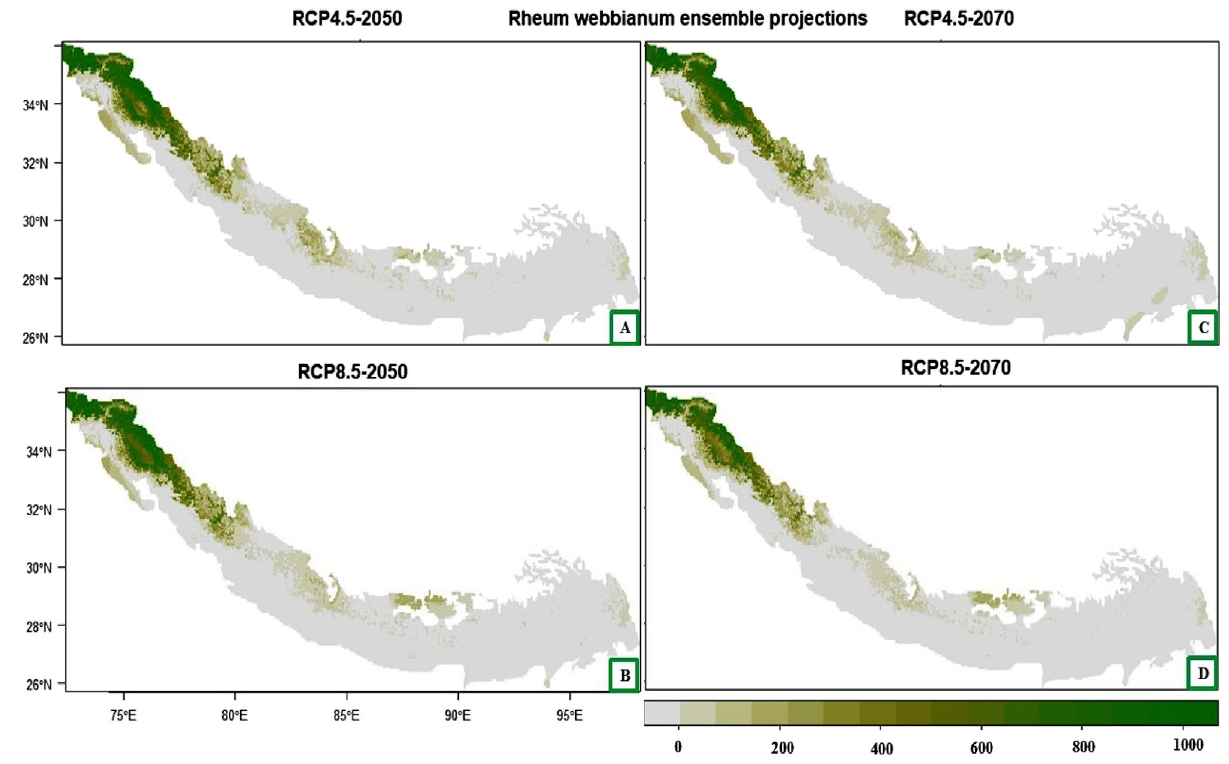
Figure 5. ( A – D ) Plot of the predicted habitat suitability for Rheum webbianum under future climate change scenarios. Scenario Loss Absent Stable Gain Loss (%) Gain (%) Range change